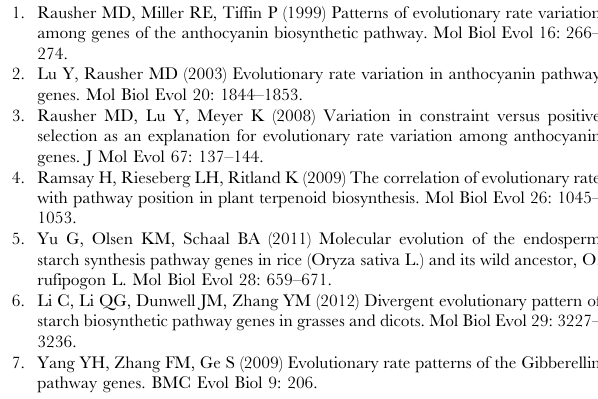
Figure S2 The aligned protein sequences of eight genes of heme biosynthesis pathway in animals.